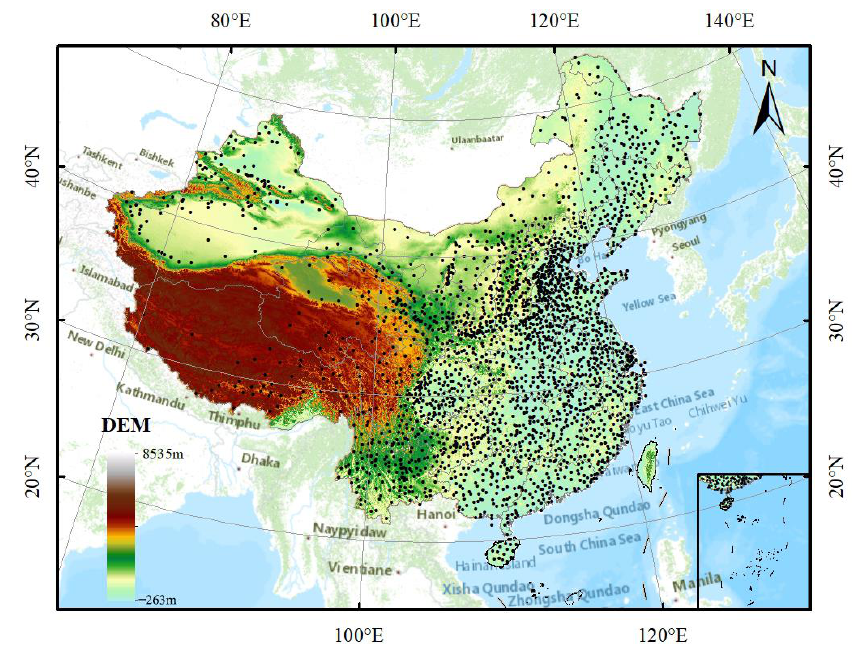
Figure 1. Distribution of rain gauge stations.